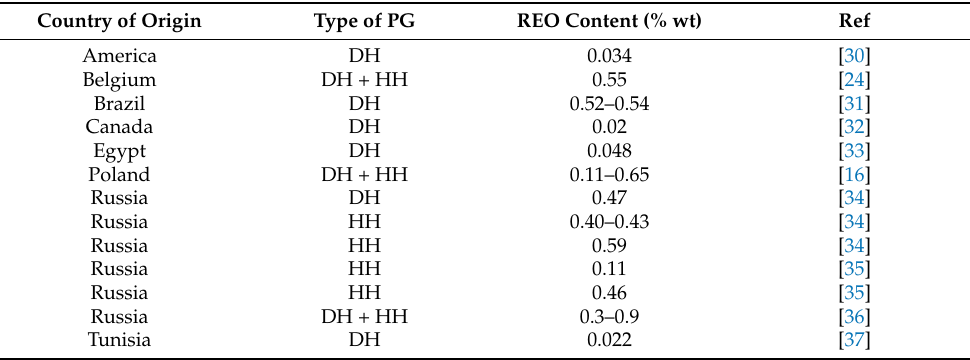
Table 2. REE content from various types of